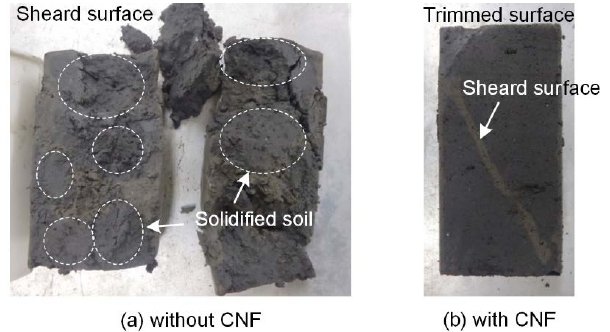
Figure 12. Appearance of sheared and trimmed surfaces (Method 2).